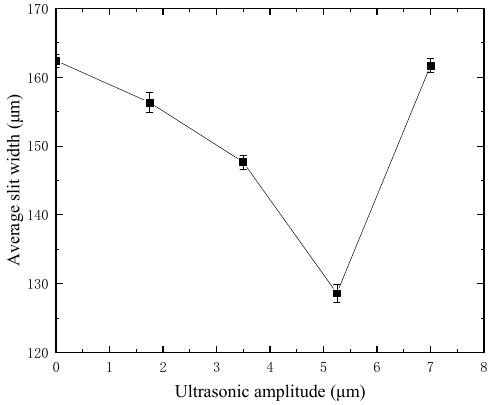
Figure 8. Slit width under different amplitude.